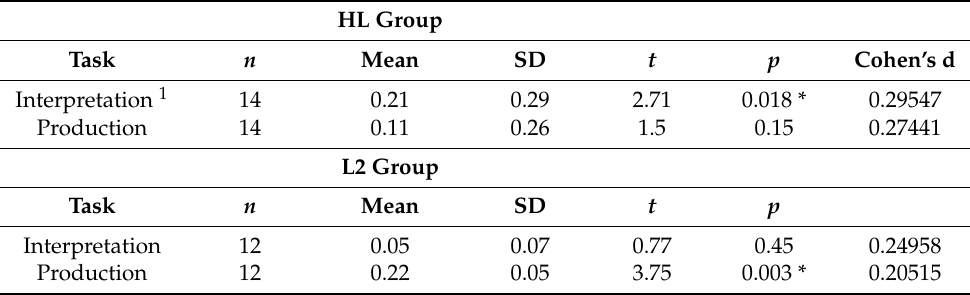
Table 3. Paired samples t -tests of HL and L2